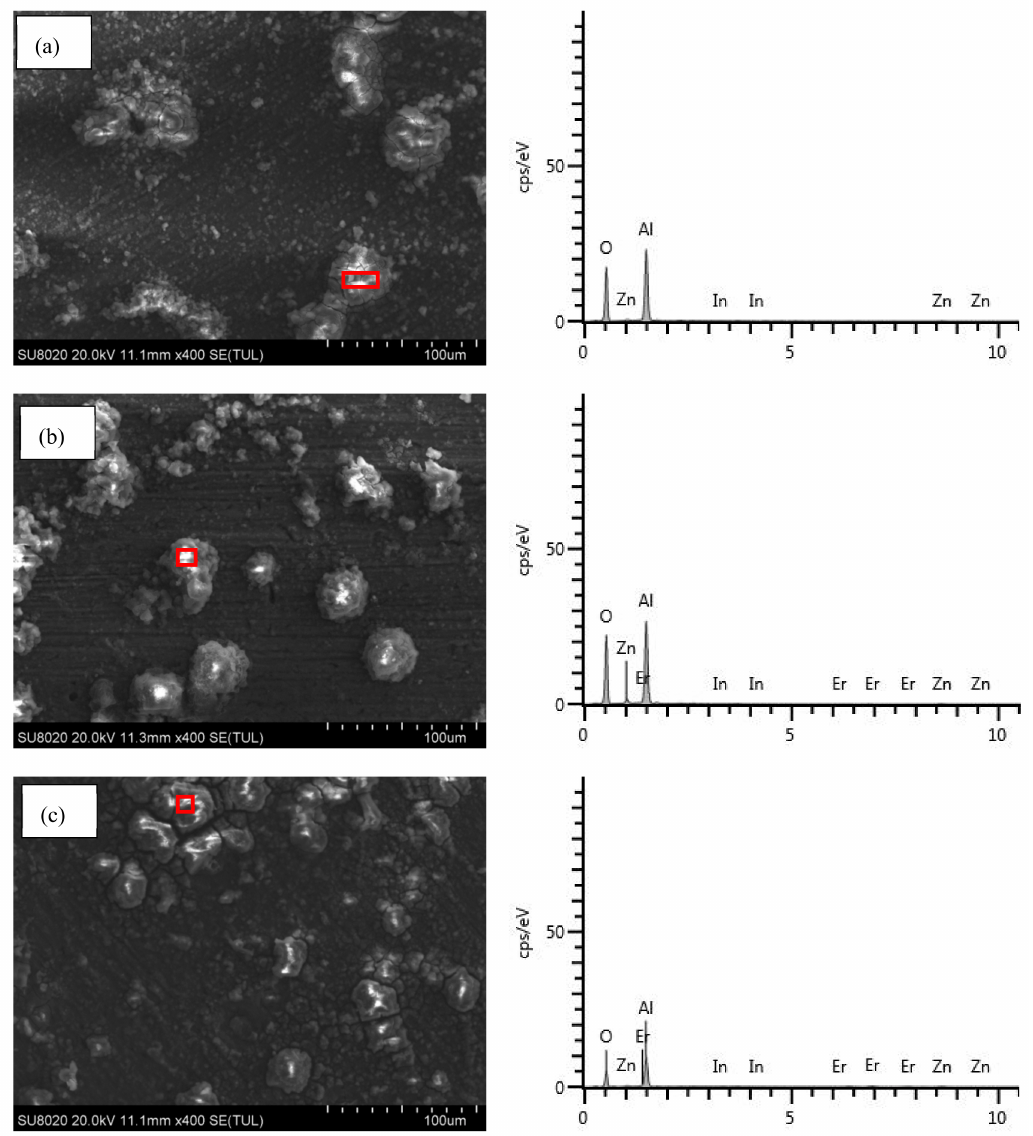
Figure 12. Corrosion morphologies and EDS analysis of Al–5Zn–0.03In– x Er alloys: ( a ) Al–5Zn–0.03In; ( b ) Al–5Zn–0.03In–1Er; ( c )